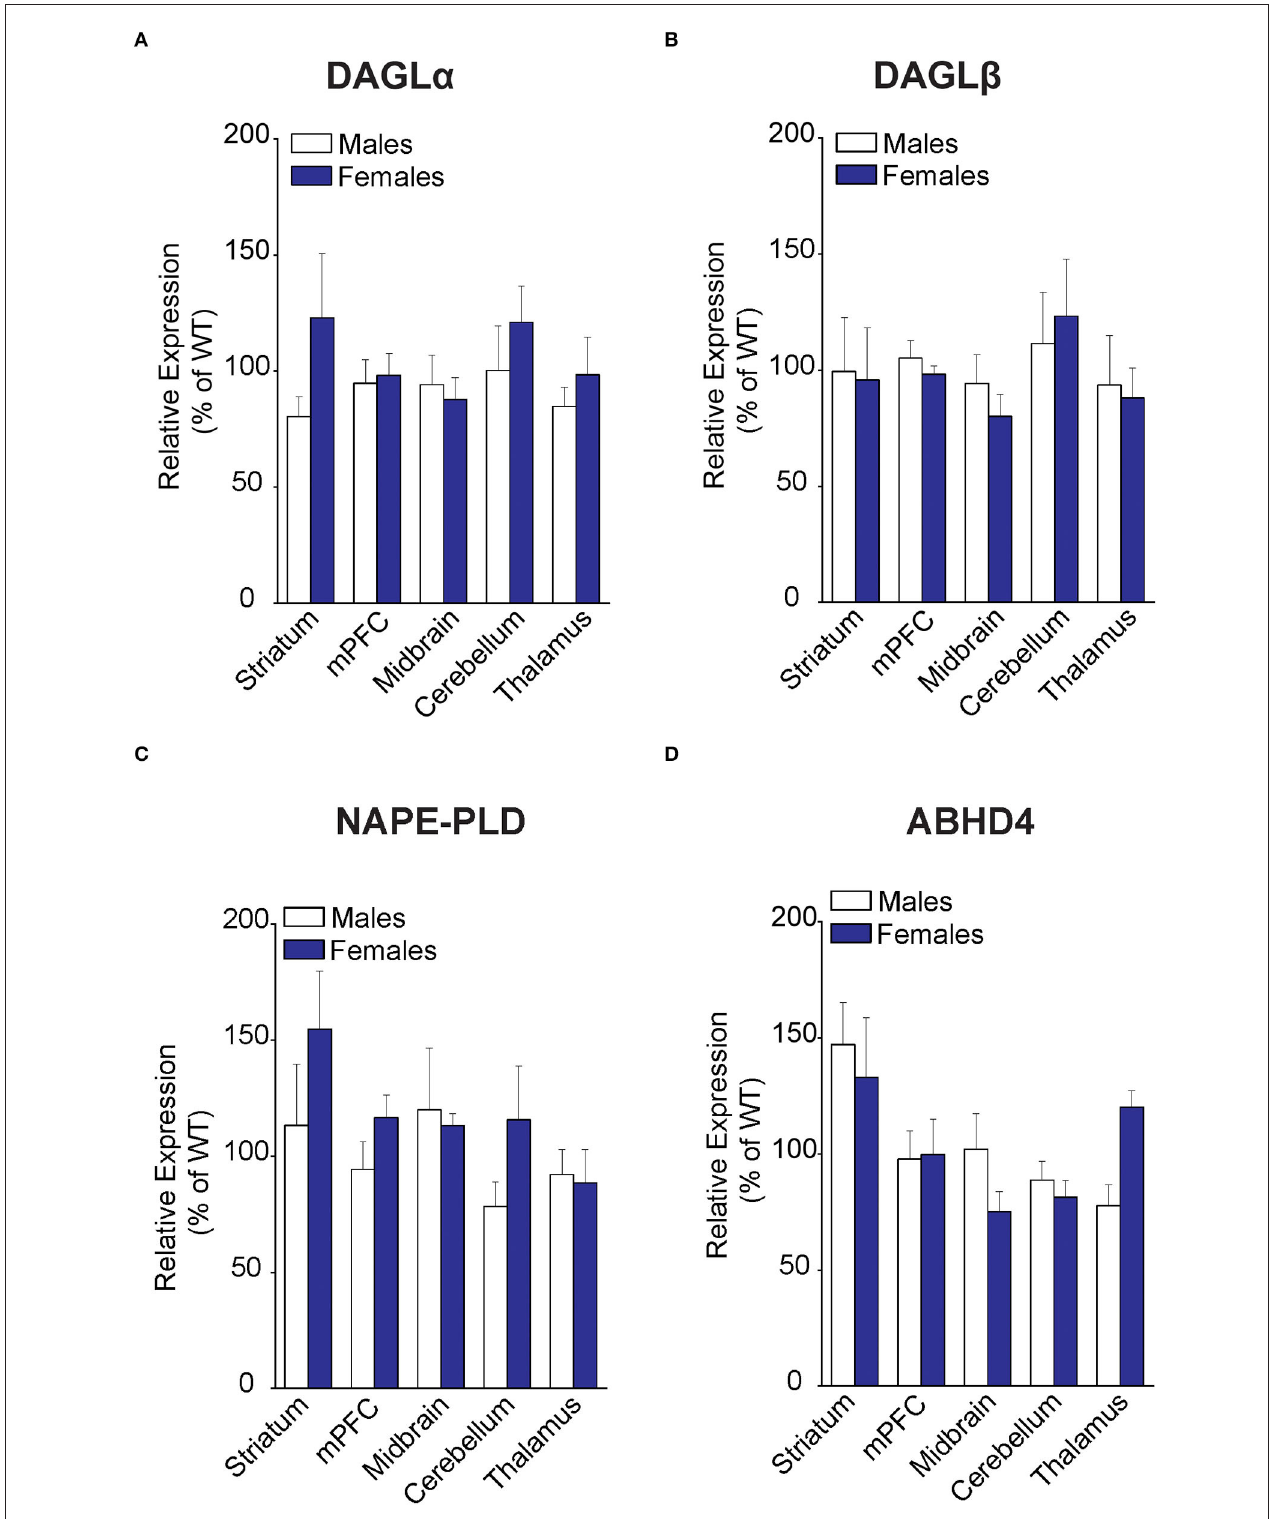
FIGURE 3 | Expression of 2-AG and AEA biosynthetic enzymes in brain regions of WT and FABP5 KO mice. (A–D) Relative expression of DAGL α , DAGL β , NAPE-PLD, and ABHD4 in male and female FABP5 KO mice compared to WT controls ( n = 5). Note that FABP5 deletion did not significantly alter the expression of these biosynthetic